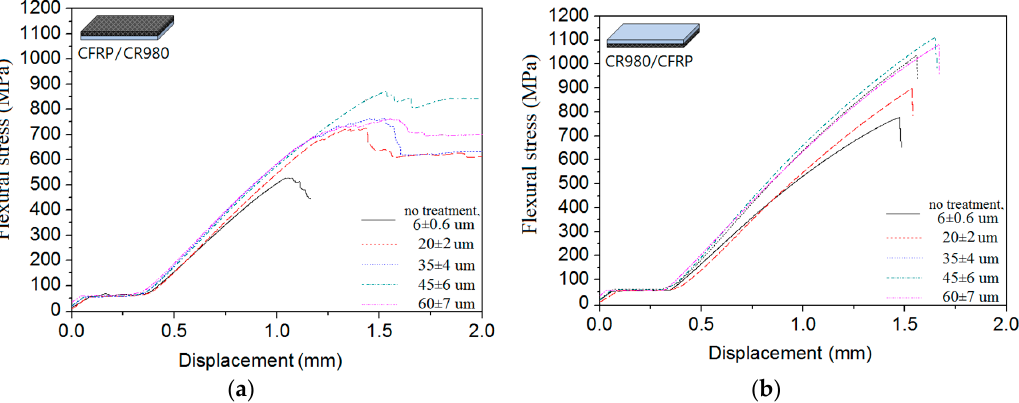
Figure 7. Flexural stress of hybrid composites according to the roughness at bonding area between CFRP and CR980: ( a ) CFRP/CR980; ( b ) CR980/CFRP. CFRP and CR980: ( a ) CFRP / CR980; ( b ) CR980 /